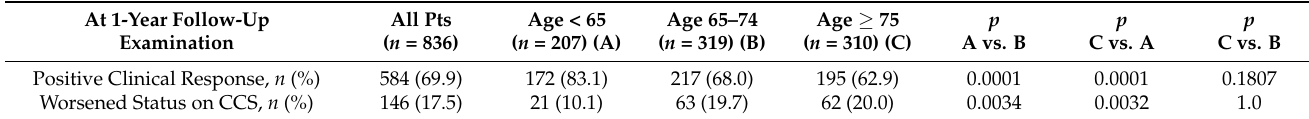
Table 2. Clinical Response and Clinical Composite Score at 1 year.